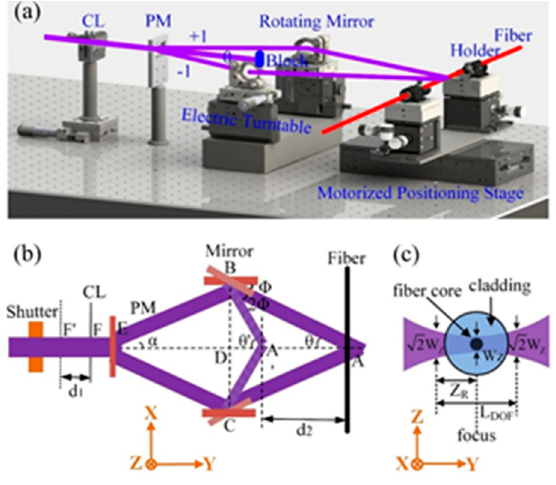
Figure 1. ( a ) Setup schematic and ( b ) optical path schematic of the proposed Talbot interferometer FBG inscription setup; ( c ) Gaussian optics model of the proposed Talbot interferometer; (CL—cylinder lens; PM—phase mask).